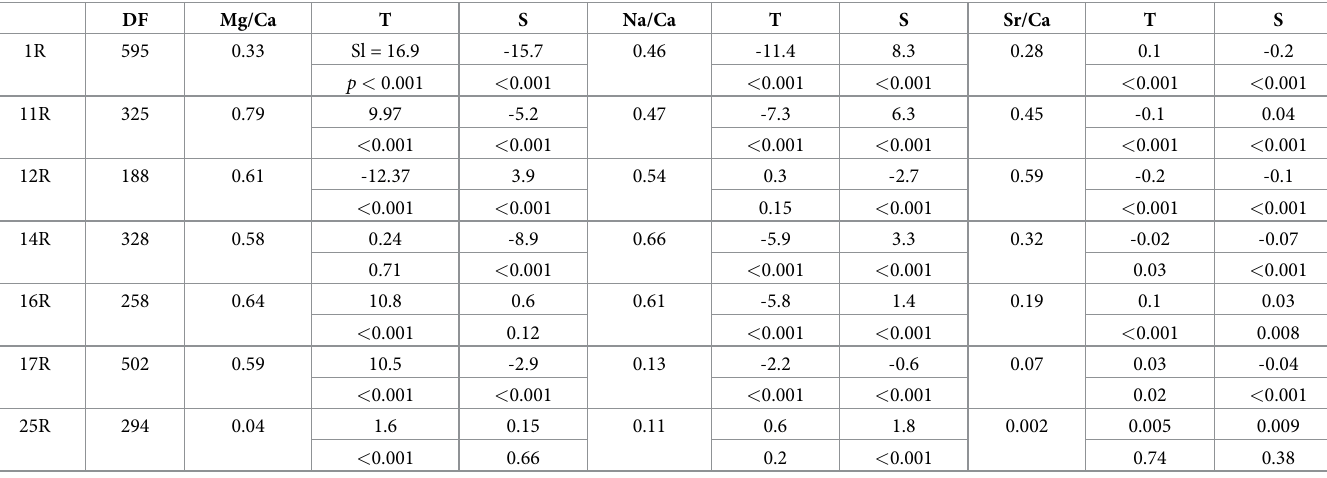
Slope = Sl and p -value of the regression are presented in column T = temperature and S = salinity. Sample 6R could not be tested as there is a particle embedded in the shell in the specific area. DF = Degrees of Freedom.